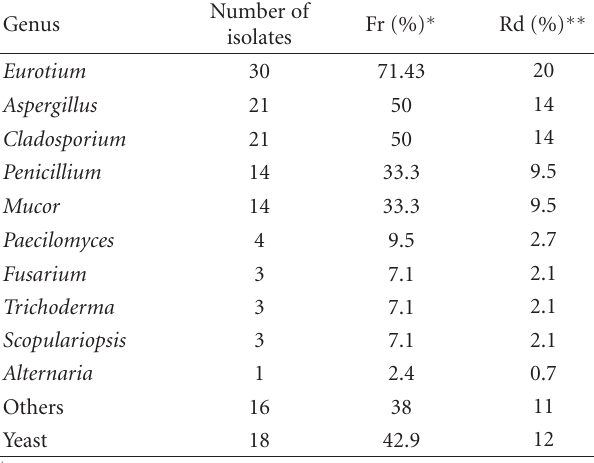
Table 2: Fungal genus present in chinchilla and rabbit feed samples.